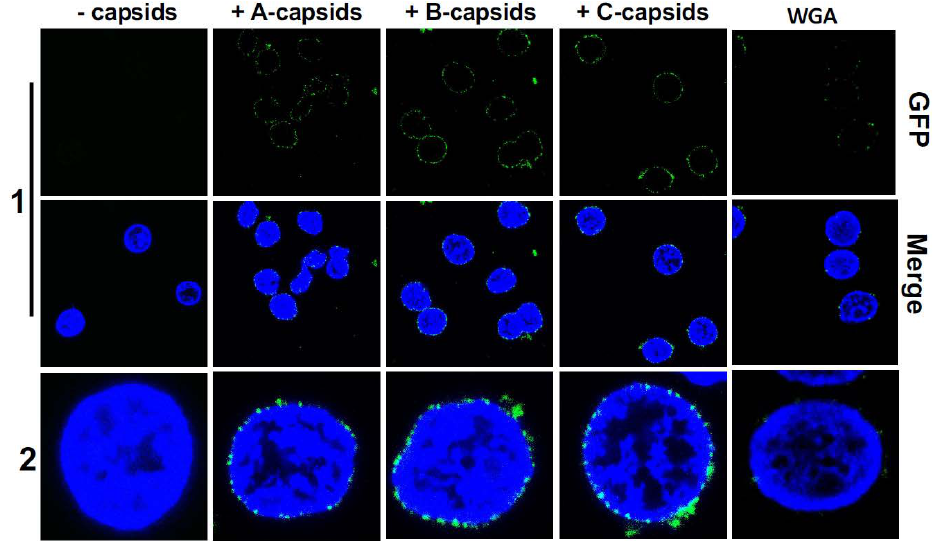
Figure 1. Imaging of reconstituted capsid-nuclei system confirms specific binding of A-, B-, and C-capsids to the NPCs at the nuclear membrane with similar occupancy. Confocal fluorescence microscopy images show binding of GFP-HSV-1 A-, B-, and C-capsids (green) to DAPI-stained isolated nuclei (blue), in the presence of cytosol and ATP-regeneration system. The addition of wheat germ agglutinin (WGA) reduces capsid binding to nuclei for all three capsid types, which demonstrates that capsids bind specifically to NPCs as opposed to binding anywhere on the nuclear membrane. One representative image of C-capsids and WGA-treated nuclei is shown.